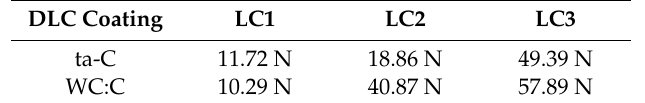
Table 2. Summary of the experimental data derived from the scratch tests with the corresponding values of critical load (LC1, LC2, and LC3) for both types of DLC coatings.